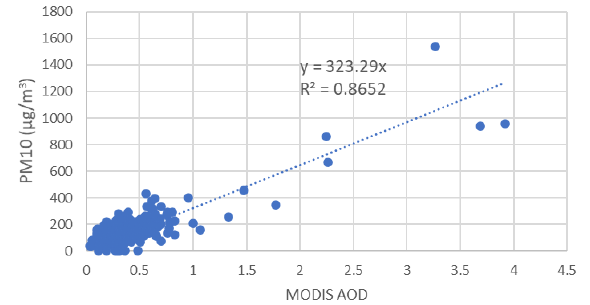
Figure 7 . Correlation between MODIS AOD and PM10 for all stations